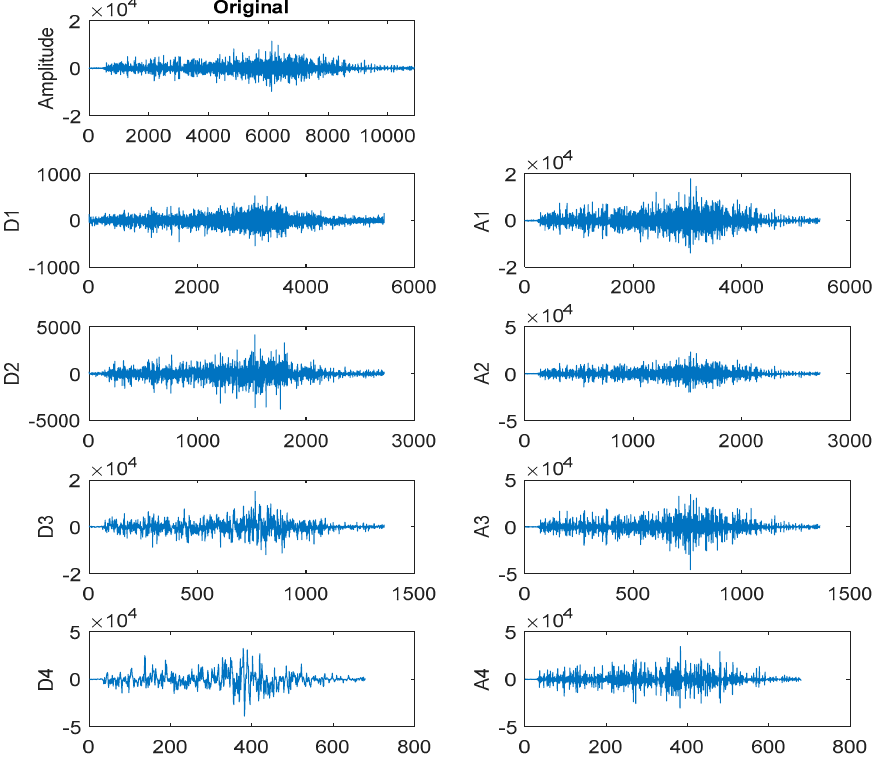
Figure 2. The illustration of the discrete wavelet transform (DWT) at fourth decomposition level.